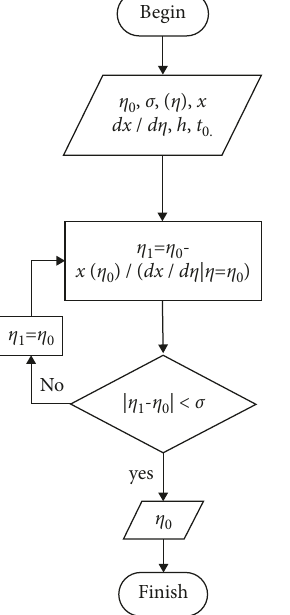
Figure 2: Block diagram of Newton’s iterative